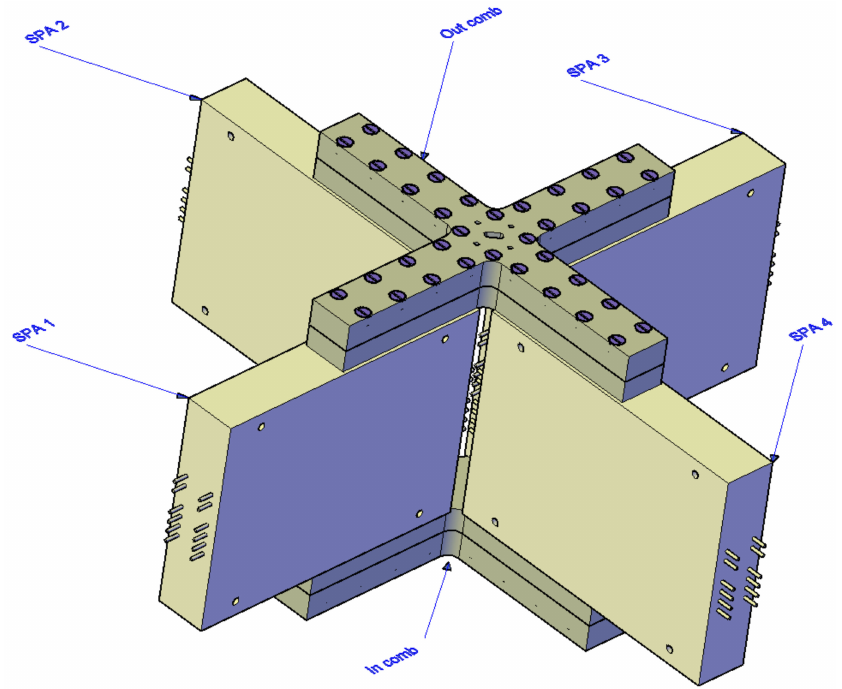
Figure 9. A representation of the complete HPA, using two combiners and four SPAs. Size is 290 × 290 × 140